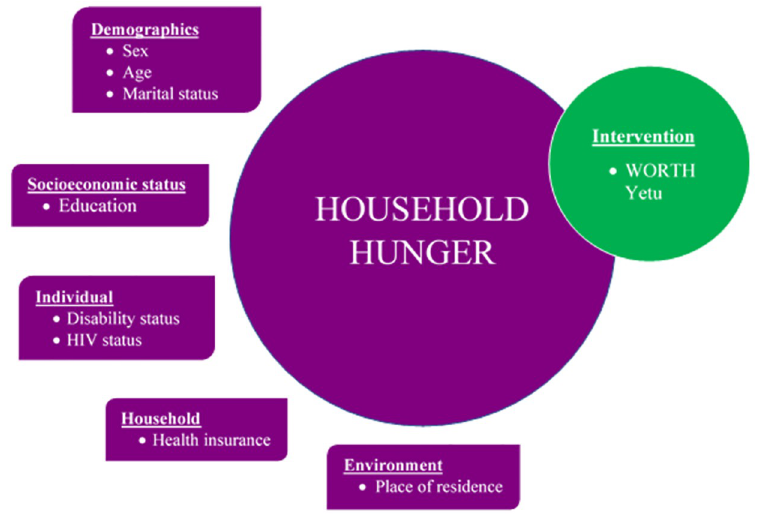
Fig 1. Conceptual framework of the effect of WORTH Yetu intervention on household hunger, considering demographic, socioeconomic, individual, household, and environmental characteristics of OVC caregivers in